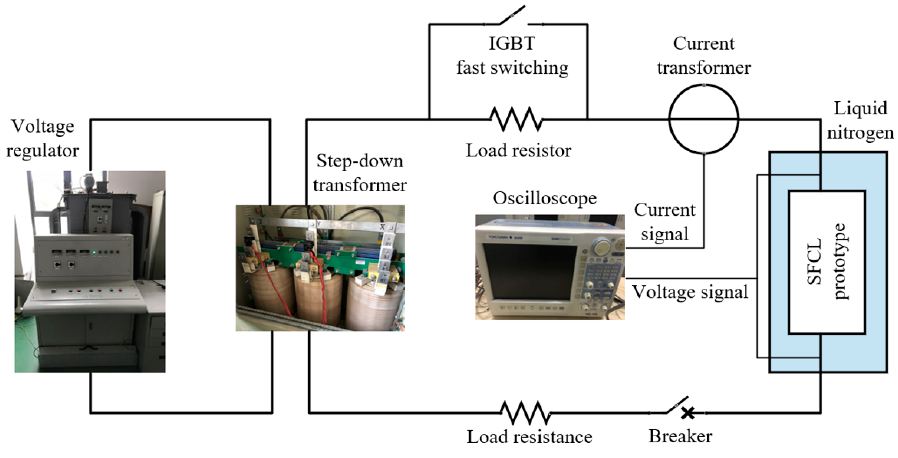
Figure 14. Short-circuit test platform.